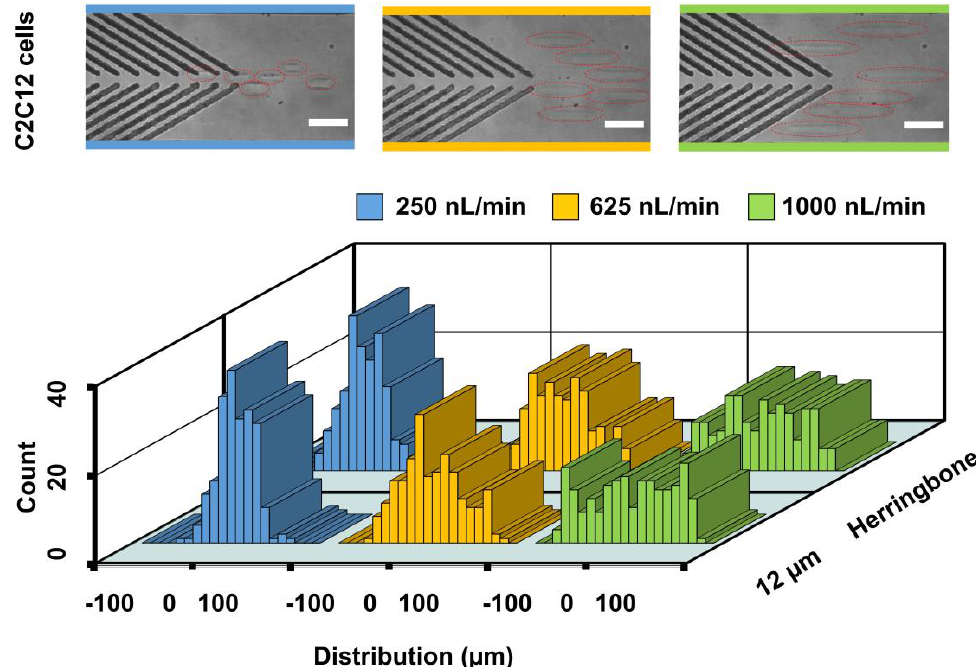
Figure 5. Distributions of C2C12 cells at the end of block 1 in the channel. The injection flow rates were 250, 625 and 1000 nL/min, respectively. The herringbone and 12-µm microstructures were used. Superimposed experimental images are shown for the cell focusing by 12-um group. The red dotted ellipses denote cells. Two hundred cells were analyzed for each group. Scale bar is 60 µm.